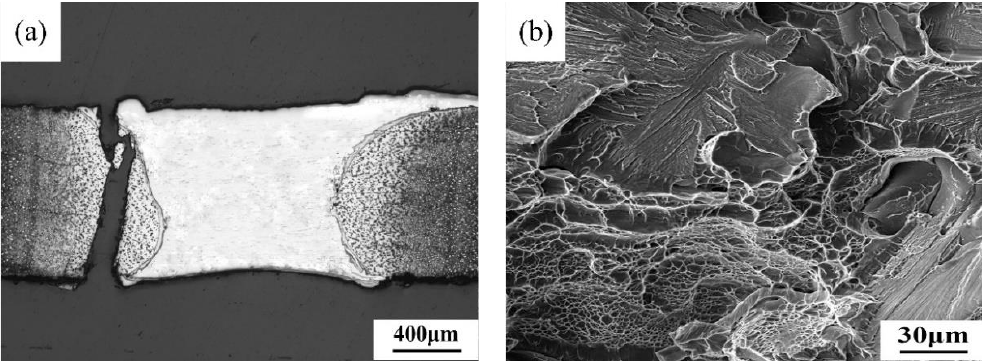
Figure 13. The fracture path ( a ) and fracture surface morphology ( b ) of joints with Nb filler metal.